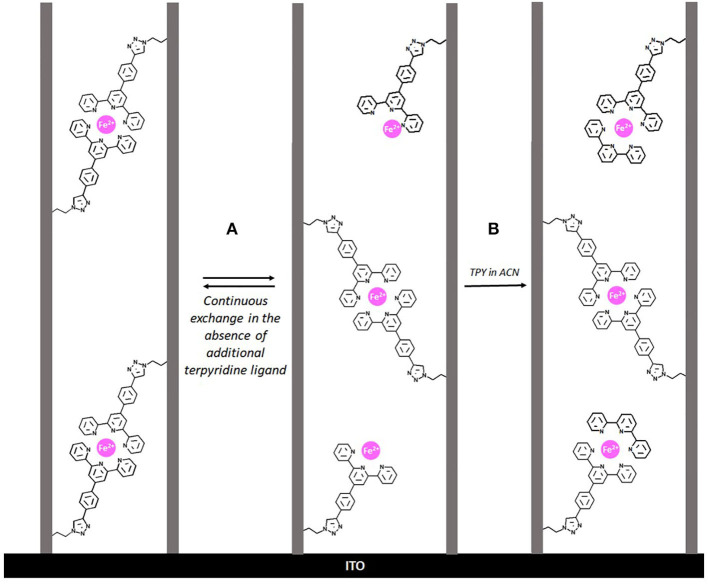
(A) Schematic representation of the continuous ligand exchange processes occurring inside the mesochannels in the case of the TEOS/AzPTES 90/10 starting films most likely due to the lability of the polypyridyl ligands coordinated to Fe(II). (B) Stabilization of the optical properties of the silica Fe(tpy)2-functionalized silica films stabilized by the addition of external terpyridine ligands.